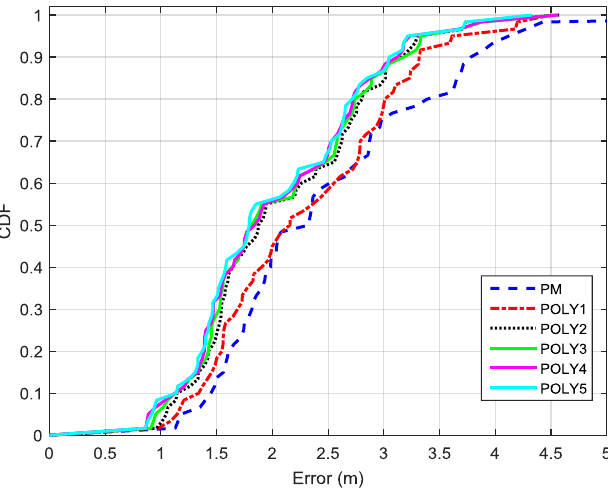
Figure 5. CDFs of 60 average distance estimation errors corresponding to 60 channel models for PM, POLY1, POLY2, POLY3, POLY4, and POLY5.